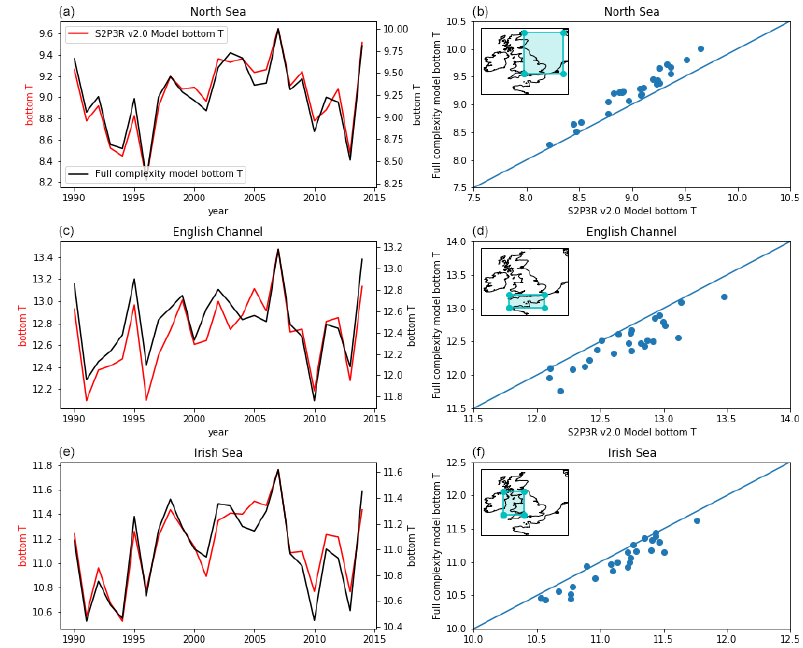
Figure 12. S2P3R v2.0 bottom water temperatures averaged annually and across the three regions highlighted in inset maps and annually bottom water temperatures from these same regions taken from a state-of-the art shelf sea model hindcast (Graham et al.,